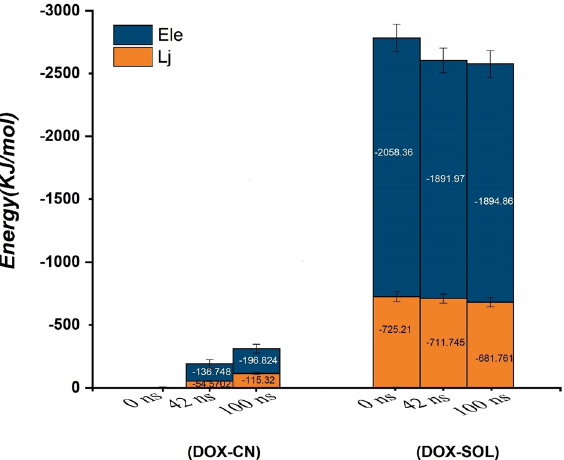
Figure 4. Average Van der Waals, electrostatic energies of the DOX-CN and DOX-SOL pairs at the three different times.